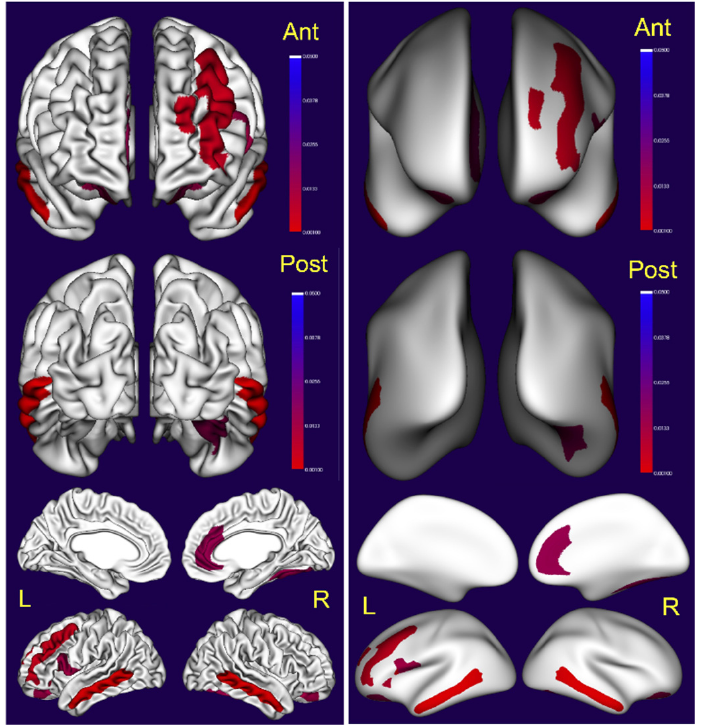
Figure 5. Visualization of the statistical significance of surface area measurements in cortical regions (left). On the right, the inflated surface. Non-significant regions are in white, significant regions (following correction for multiple comparison) are shown in blue ( p < 0.05) to red ( p <